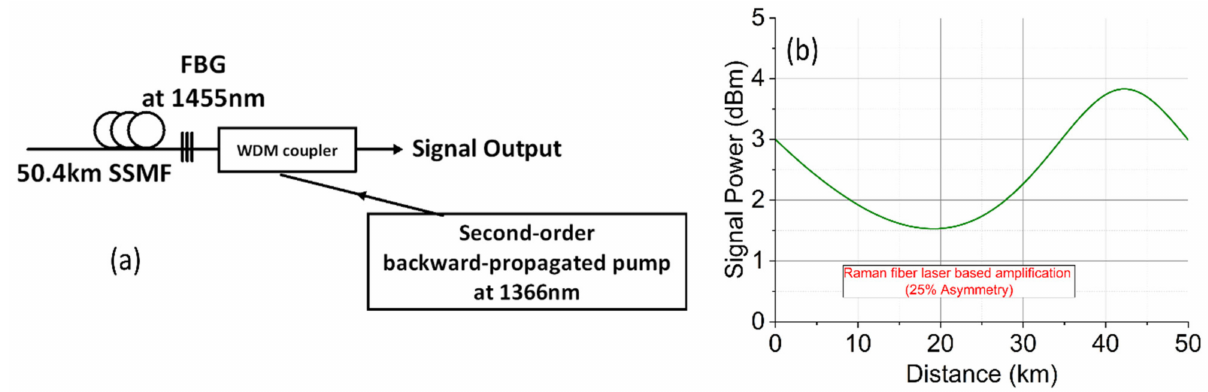
Figure 2. ( a ) Dual-order backward pumping; ( b ) signal power profiles along the fiber.